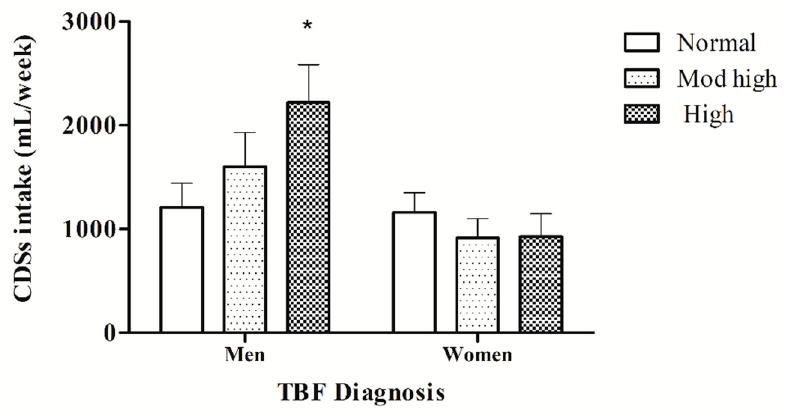
Figure 1. CSD consumption based on TBF% diagnosis. CSD intake is reported as the mean ± standard error of each group differentiated by a diagnosis of TBF% (normal, moderately high, and high) between men and woman. * p < 0.05 compared to the normal TBF% group, as per one-way ANOVA.